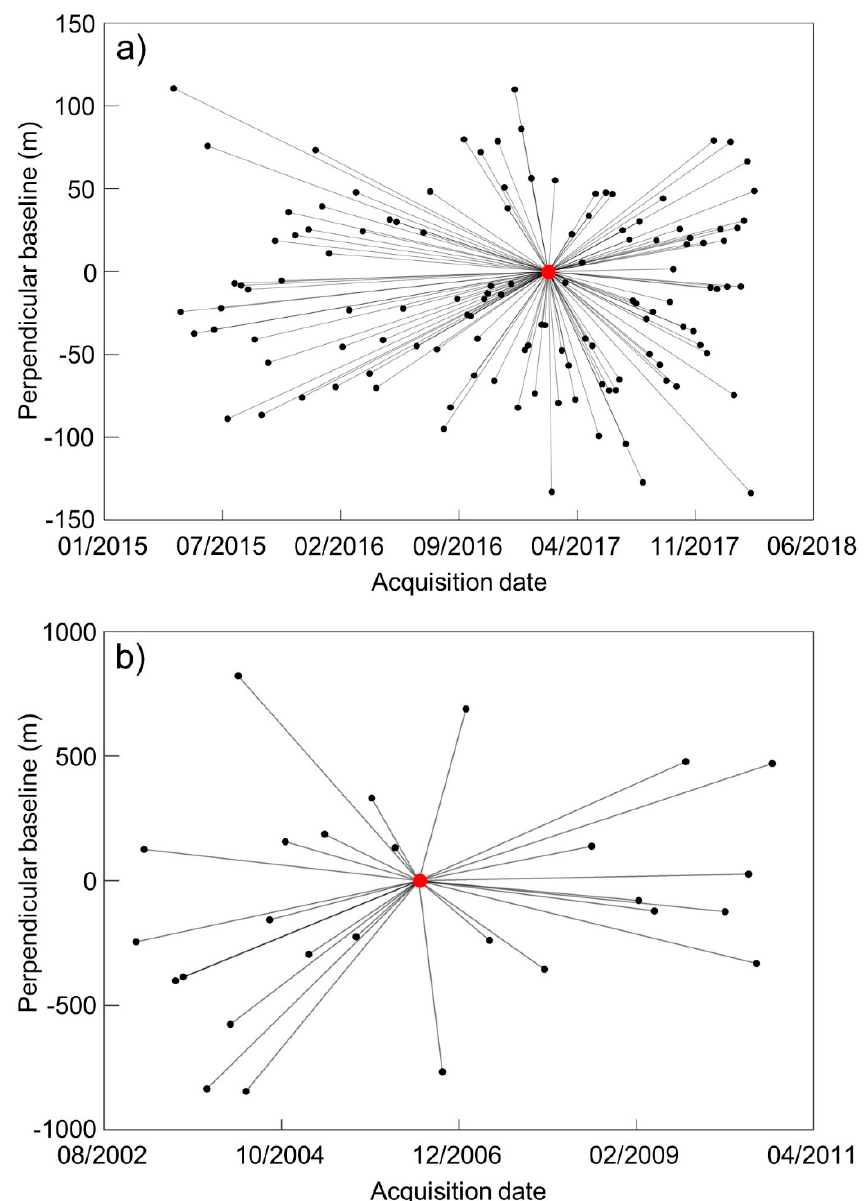
Figure 6. Examples of connection graph between the master (red dot) and slave (black dots) images generated with the PS-InSAR approach. The graphs are obtained from ( a ) the descending Sentinel-1A/B dataset, track 96, and ( b ) the descending ENVISAT dataset, track 352, both acquired over AOI-1.